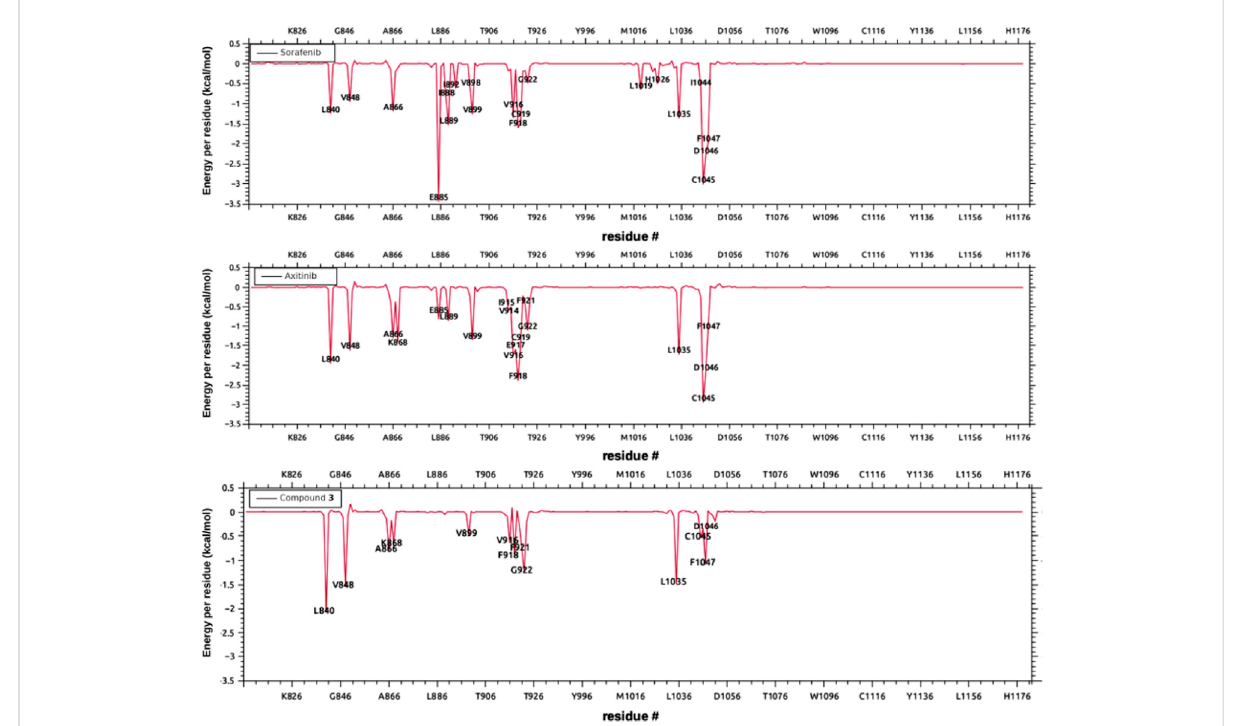
FIGURE 7 Decompositiononperresiduebasisofthecontributionofeachaminoacidtothefreeenergyofbinding,fromtoptobottom:sorafenib,axitinib and compound 3